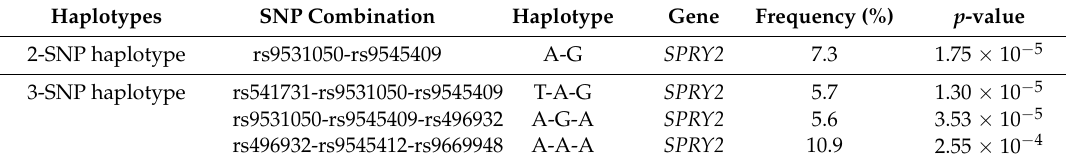
Table 1. The haplotypes in SPRY genes showing significant association with the risk of NSCL/P among 806 Chinese trios after Bonferroni correction 1